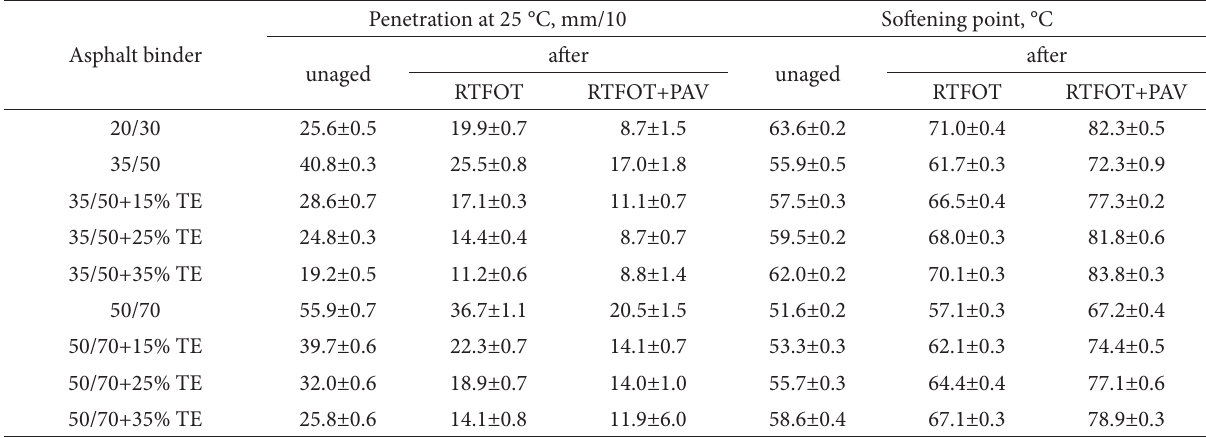
Table 2. The values of penetration and softening point for the Trinidad Epuré modified asphalt binders